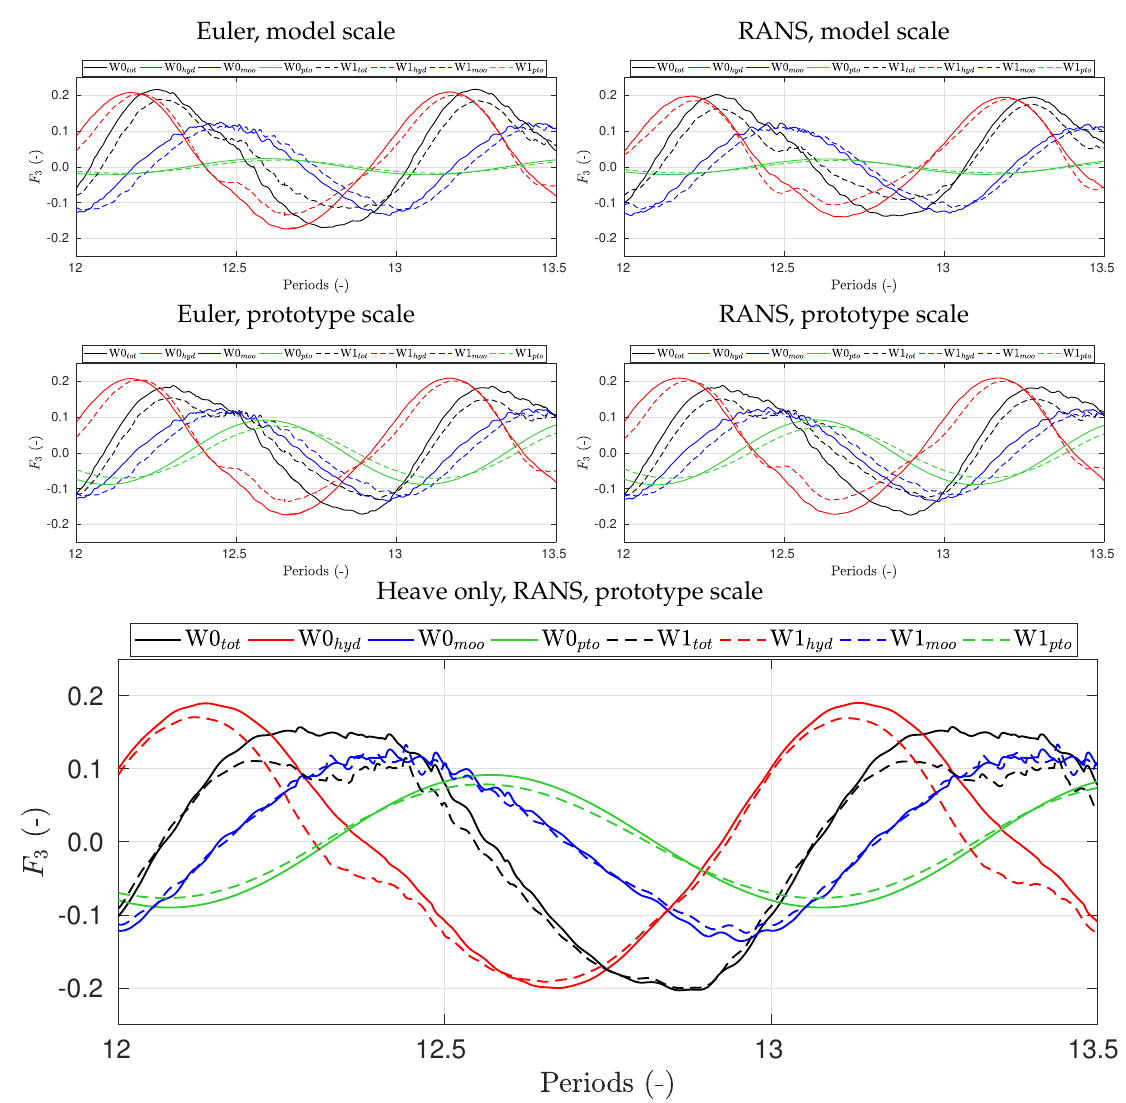
Figure 7. Force decomposition depending on wave steepness (W0-solid lines, W1-dashed lines). From the power take-off force ( F pto ), we can compute the mean power